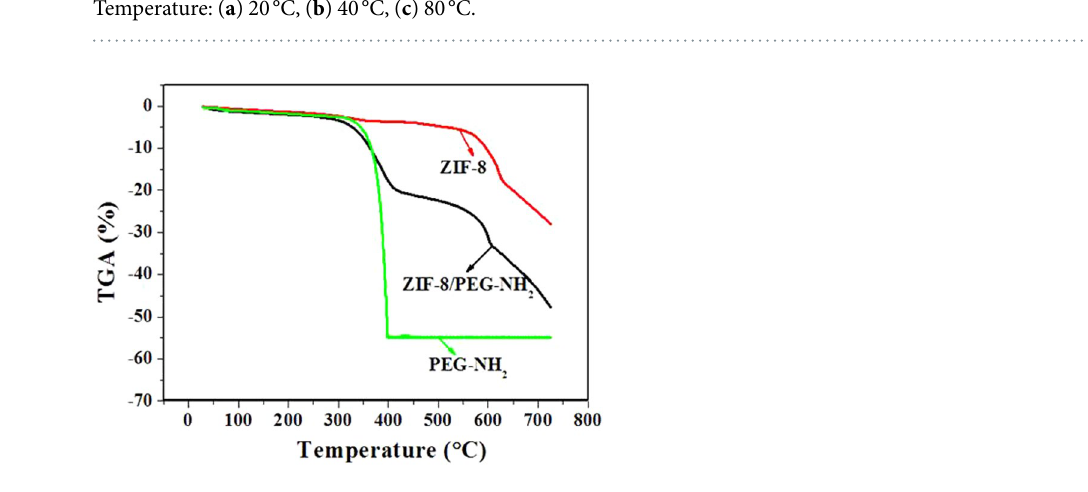
Figure 5. SEM images ( a – c ) of the ZIF-8/PEG-NH 2 composites prepared at different temperatures. Temperature: ( a ) 20 °C, ( b ) 40 °C, ( c ) 80 °C.